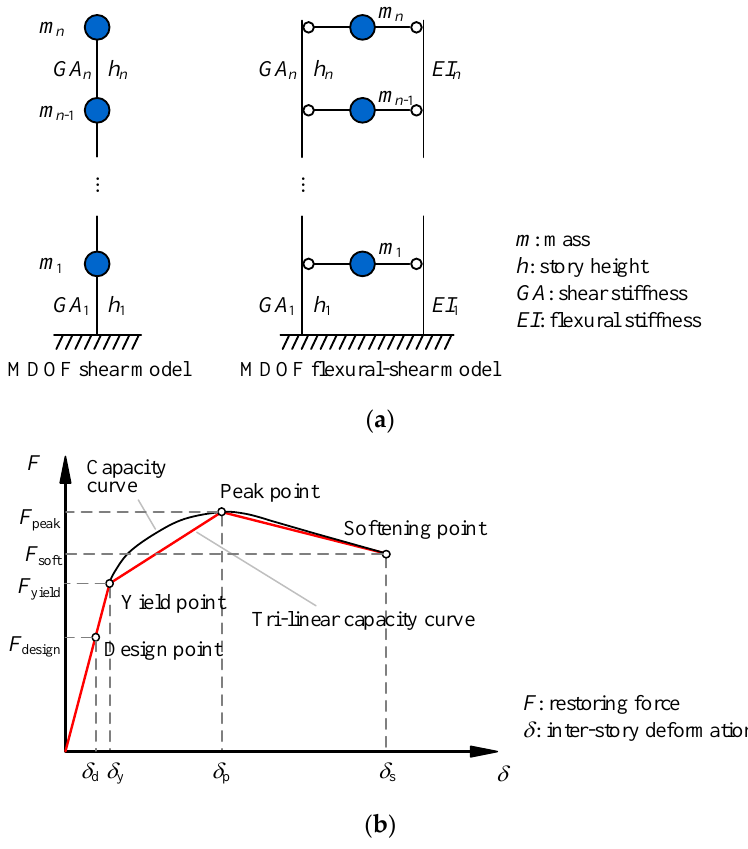
Figure 2. Brief illustration of the adopted nonlinear MDOF models. ( a ) MDOF model; ( b ) inter-story force–displacement